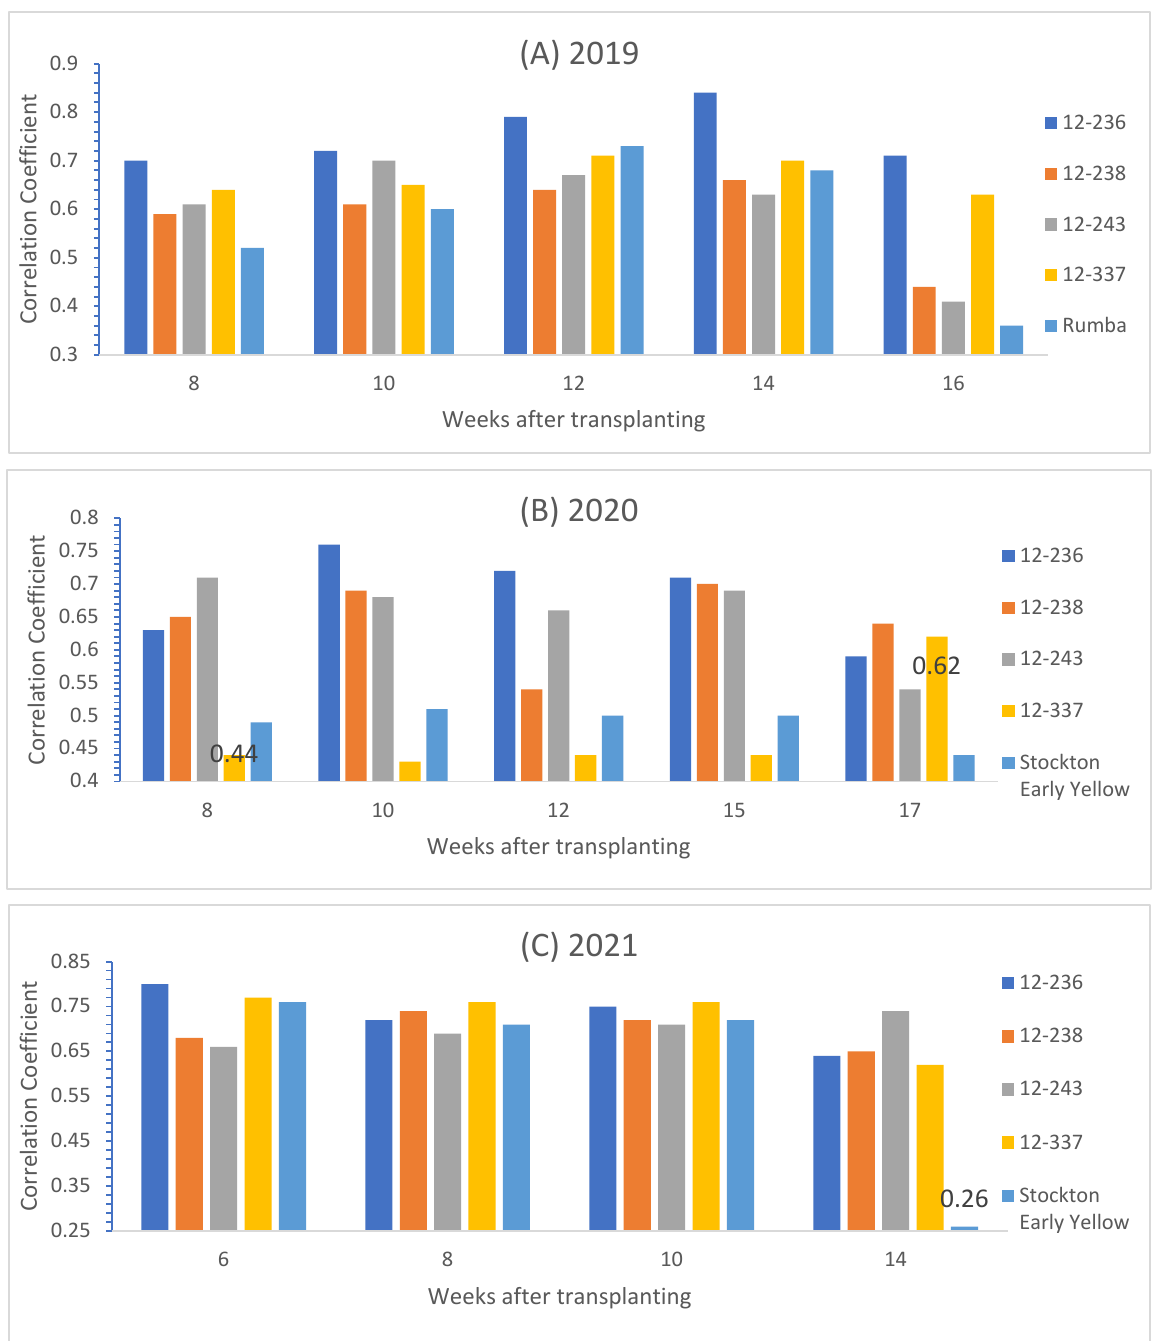
Figure 6. Correlations between bulb weight and plant height through the growing season and for entries on per plant basis in ( A ) 2019, ( B ) 2020 and ( C ) 2021, at p < 0.001 significance level.